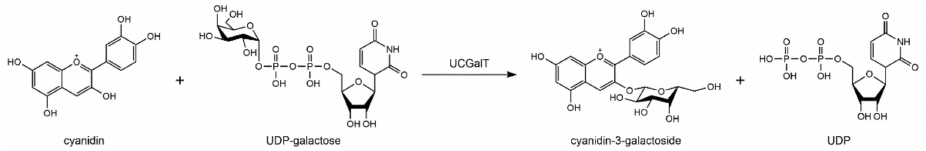
Figure 3. Formation of cyanidin 3- O -galactoside from cyanidin and UDP-galactose. UDP-galactose is mainly from the intermediates in the production of polysaccharides via nucleotide sugars metabolism in plants [26]. It can be synthesized through two routes: from UDP-glucose mediated either by UDP-glucose 4-epimerase or by galactokinase and galactose-1-phosphate uridyl transferase in the presence of galactose [27]. Additionally, O -methyltransferase (OMT) catalyzes the formation of malvidin, peonidin, petunidin, and their corresponding glycosylated forms from cyanidin, delphinidin, and corresponding an- thocyanins (Figure 2) [28]. After their biosynthesis, these flavonoids would be transported to the vacuoles or cell walls of plants